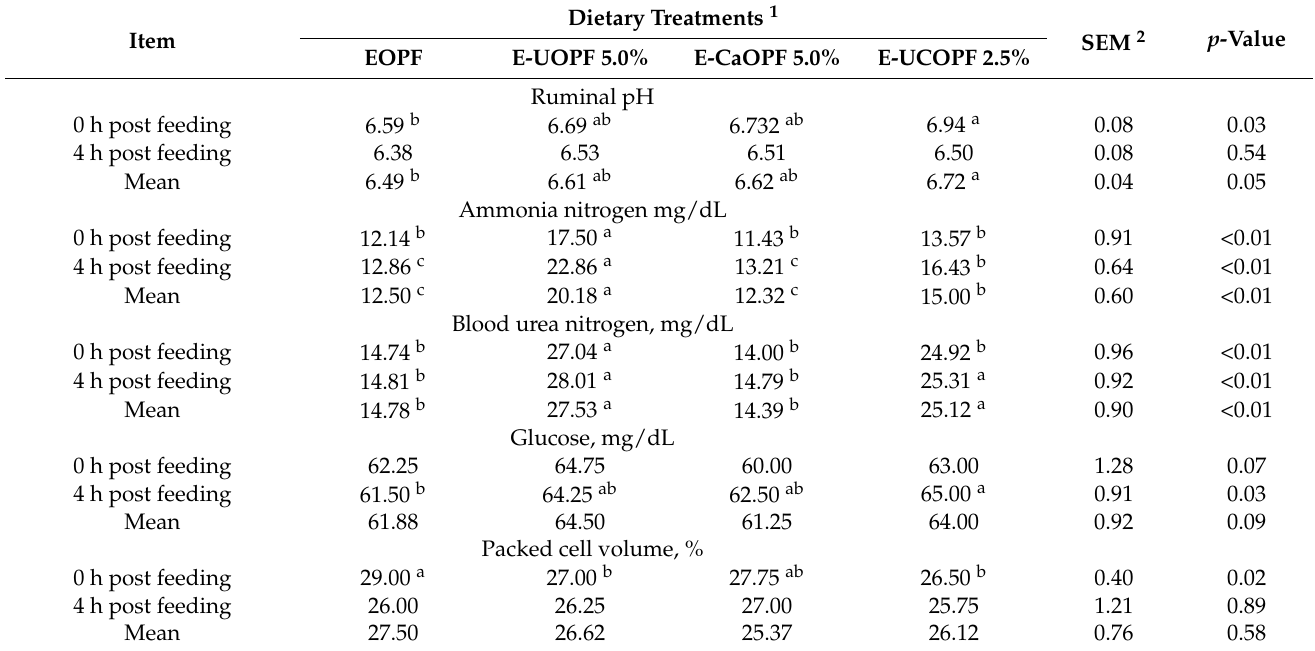
Table 5. Effect of ensiled oil palm fronds supplemented with urea-calcium hydroxide on ruminal pH, NH 3 -N, and blood metabolites in